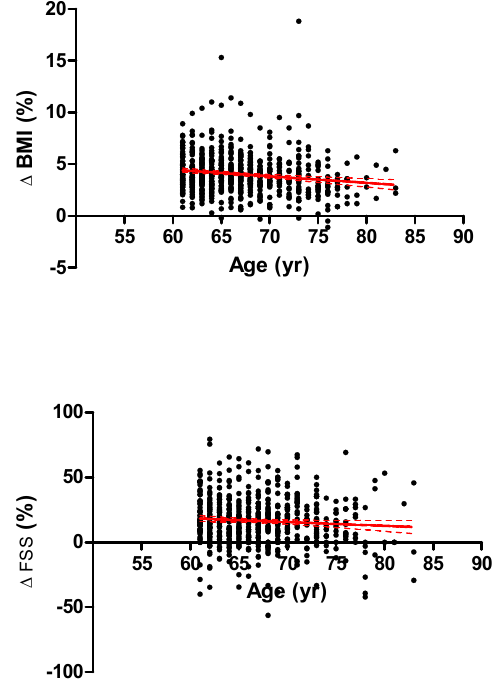
Figure 4. Correlations of age with changes in body mass index ( ∆ BMI, top panel) or fatigue severity scale ( ∆ FSS,) score (bottom panel) before and after a three-week body weight reduction program (POST-PRE-BWRP) in elderly obese females and males. The results of the linear regression analysis are reported (i.e., the best fitted line for all data together with 95% confidence interval).